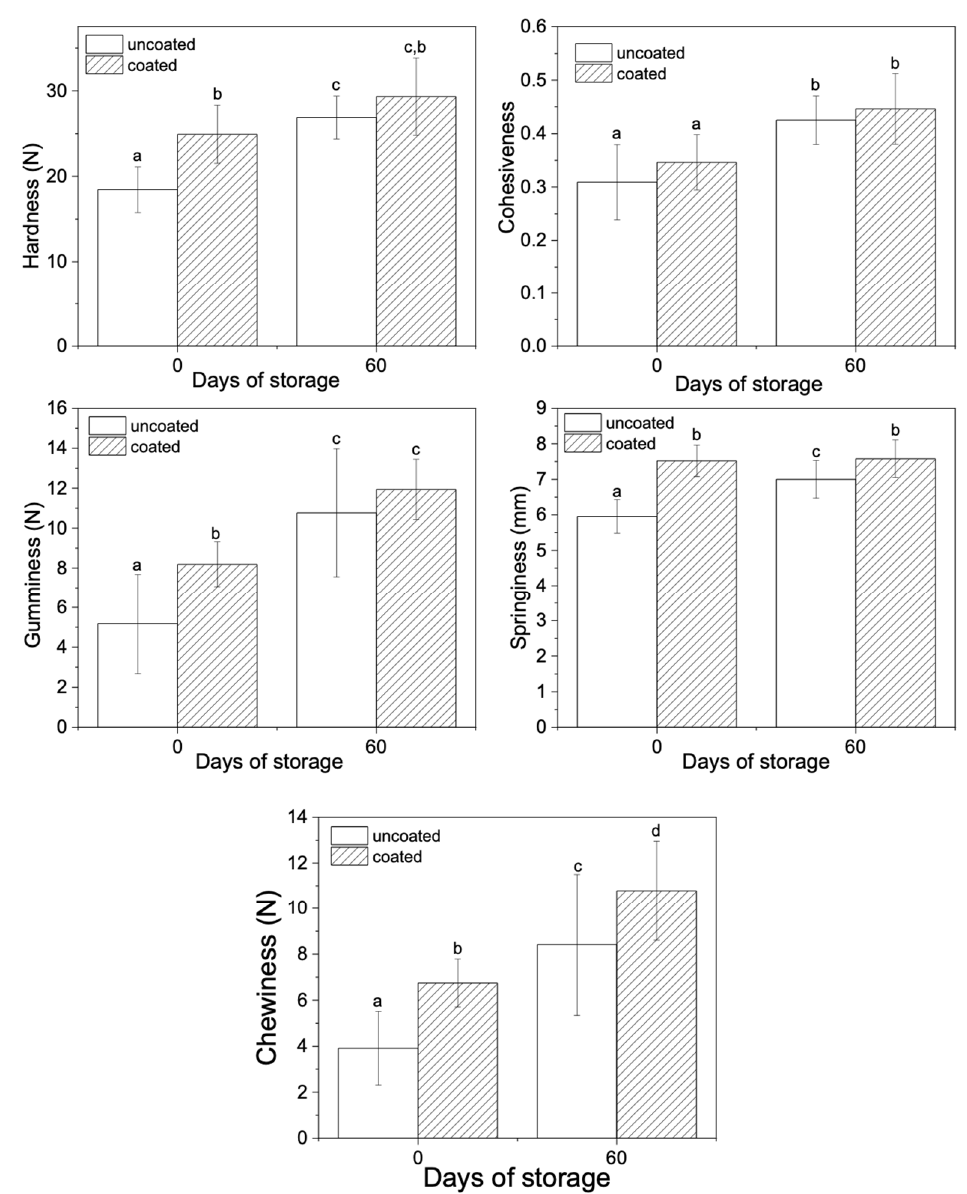
Figure 2. Parameters derived from the texture profile analysis of the uncoated and coated Paipa cheese samples for the initial time and day 60 of storage. Bars with different letters (a, b, c, d) showed statistical difference ( p < 0.05).